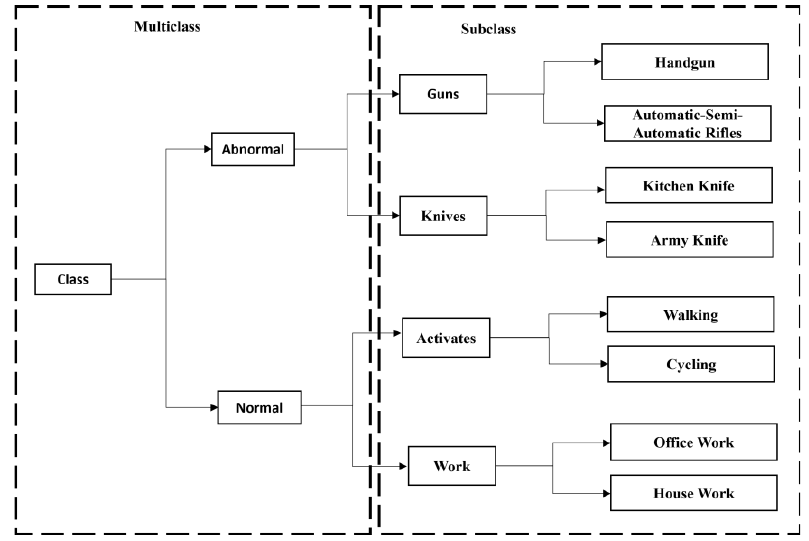
Figure 3. Illustration of multiclass subclass sequential flow. The dashed arrow indicates the abnormal subclass; the dotted arrow indicates the normal subclass. The right-side box indicates the major multiclasses; the left-side box indicates their respective subclasses.